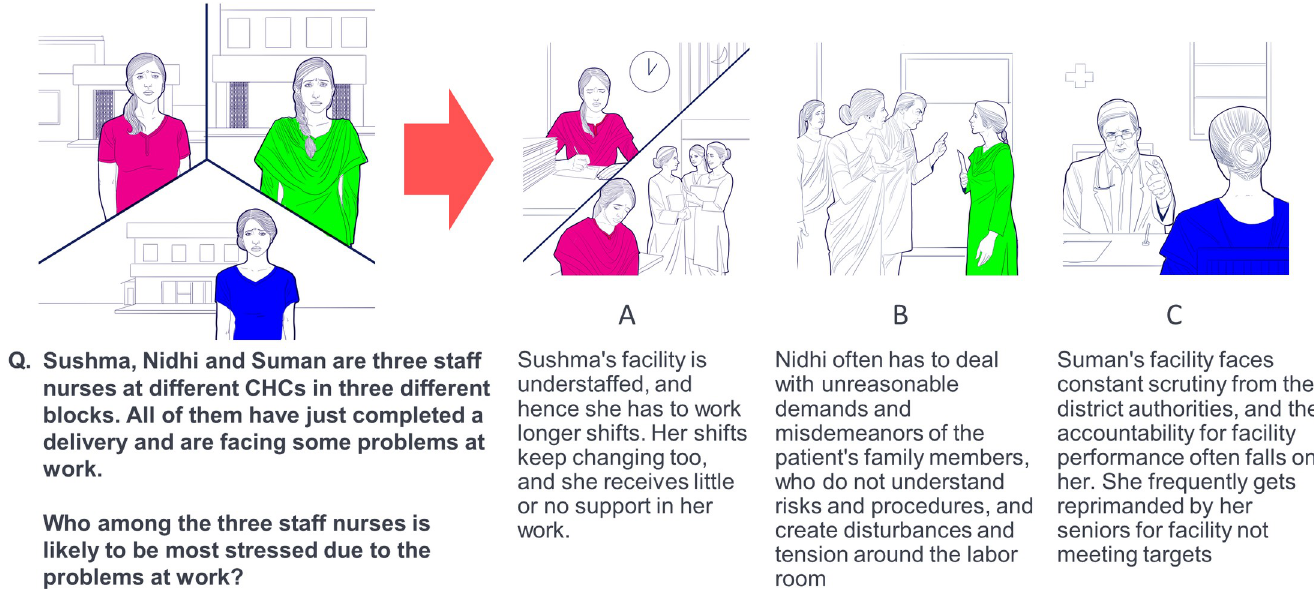
Fig 3. Sample decision-making game scenario. The text was played via speaker to participants, who selected one answer. This scenario investigated the focus areas ‘Stress and coping mechanisms’ and ‘Reluctance of patients’ (see Fig 4).